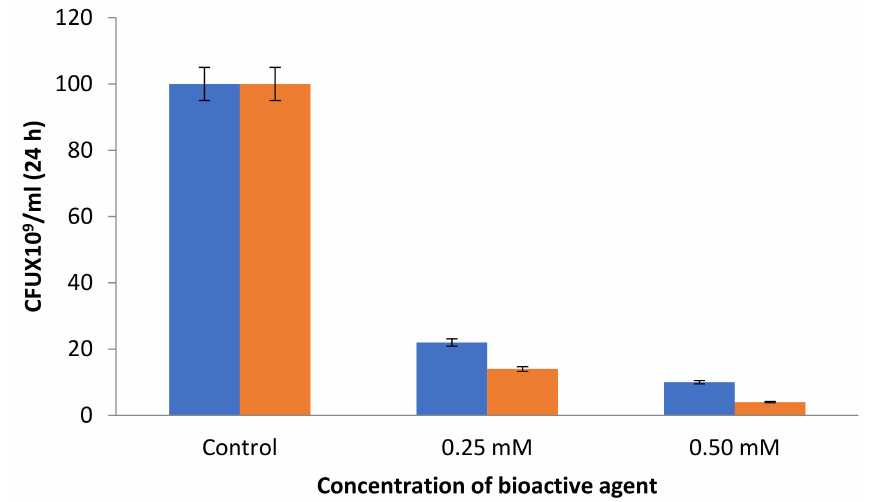
Figure 3. CFU by the synthesized AgNPS ( (cid:3) ) and BAC-coated AgNPs ( (cid:3)